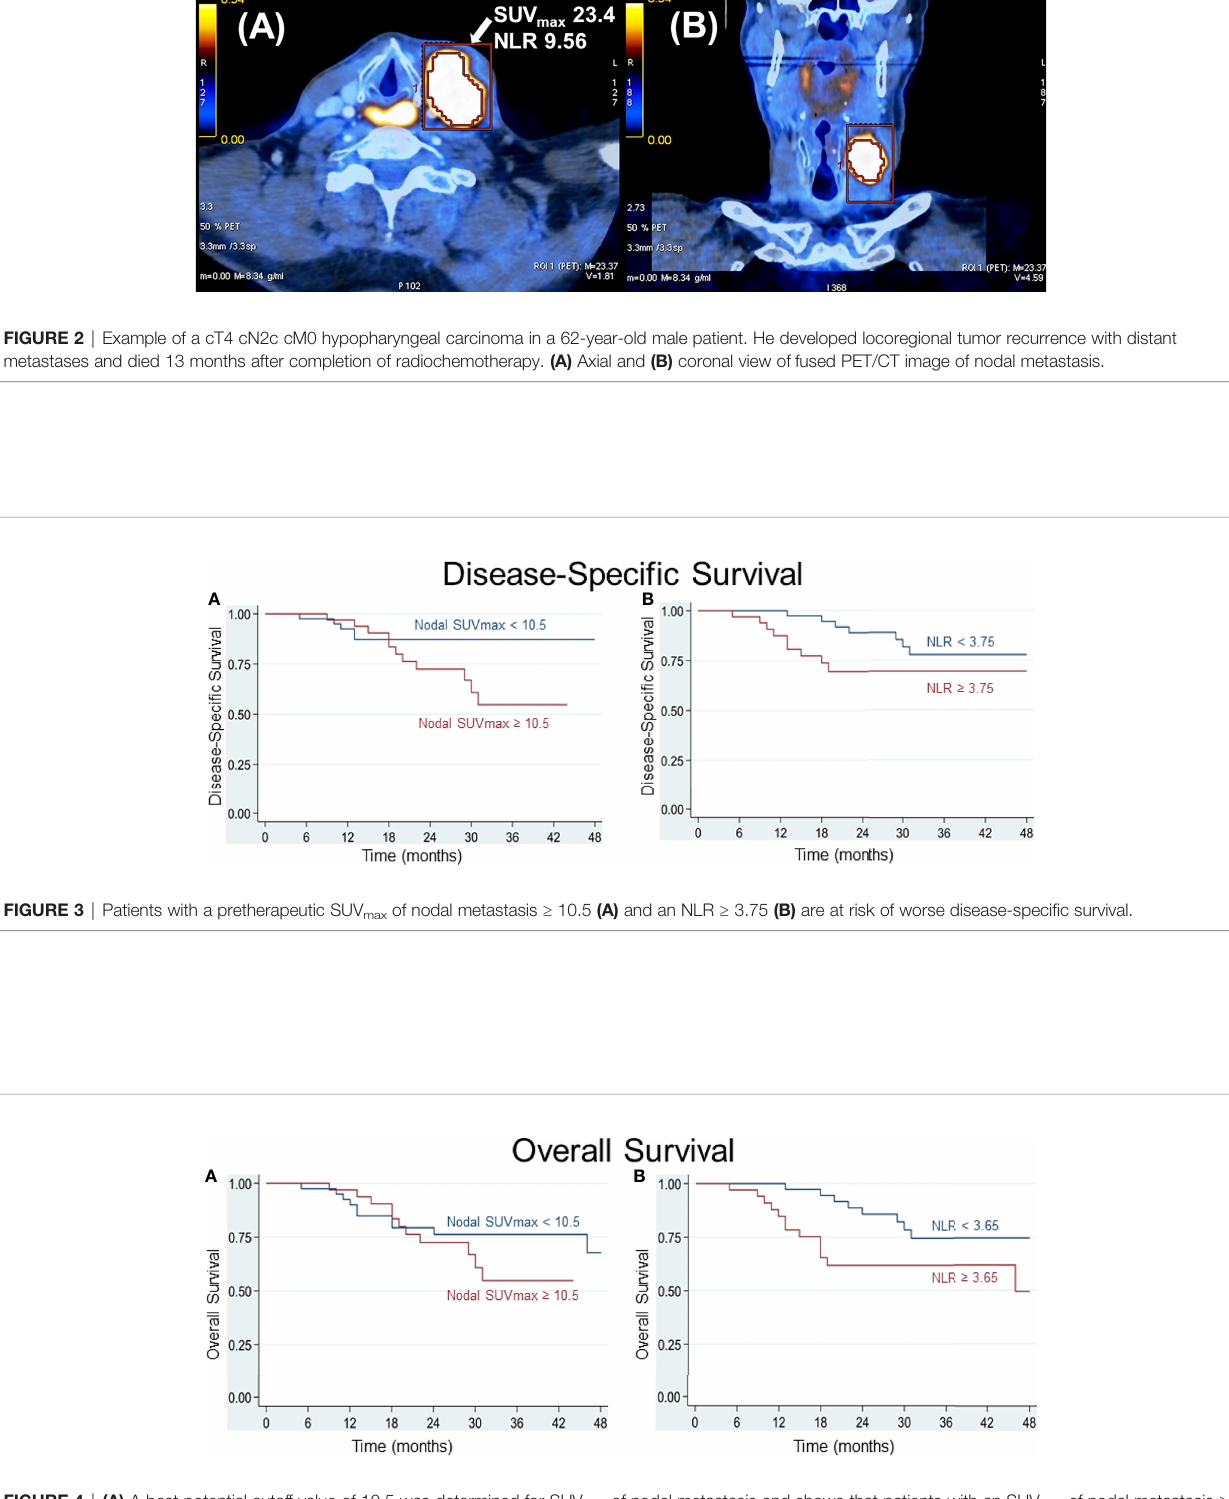
FIGURE 4 | (A) A best potential cutoff value of 10.5 was determined for SUV max of nodal metastasis and shows that patients with an SUV max of nodal metastasis ≥ 10.5 are at greater risk of dying. (B) An NLR ≥ 3.65 distinguished best between patients at lower (NLR < 3.65) and higher (NLR ≥ 3.65) risk of